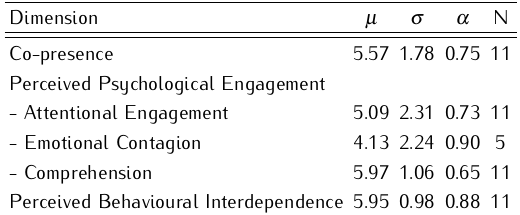
Table 11. Summary of response among the social presence dimensions in the Networked Minds. Psycho-behavioural Interaction has four sub- dimensions; Attentional Engagement, Emotional Contagion, Com- prehension and Perceived Behavioural